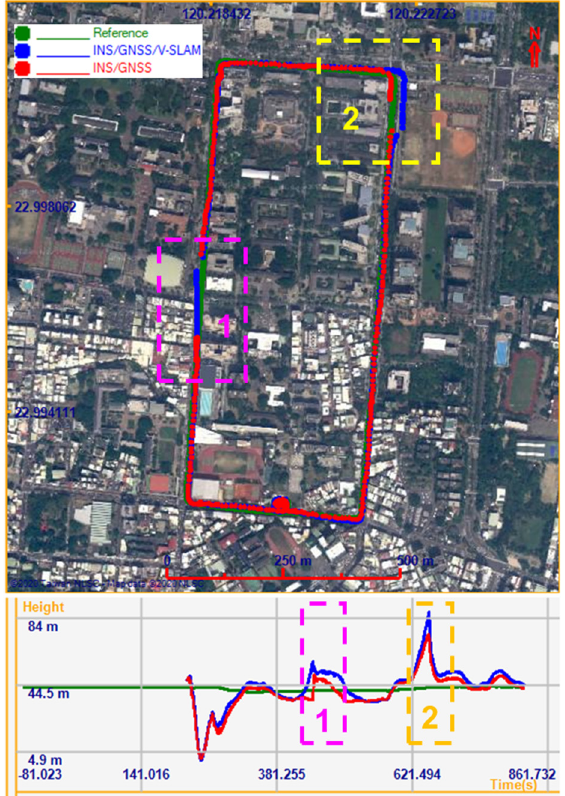
Figure 13. Trajectories of the various solutions with planned GNSS signal outage in the first test.